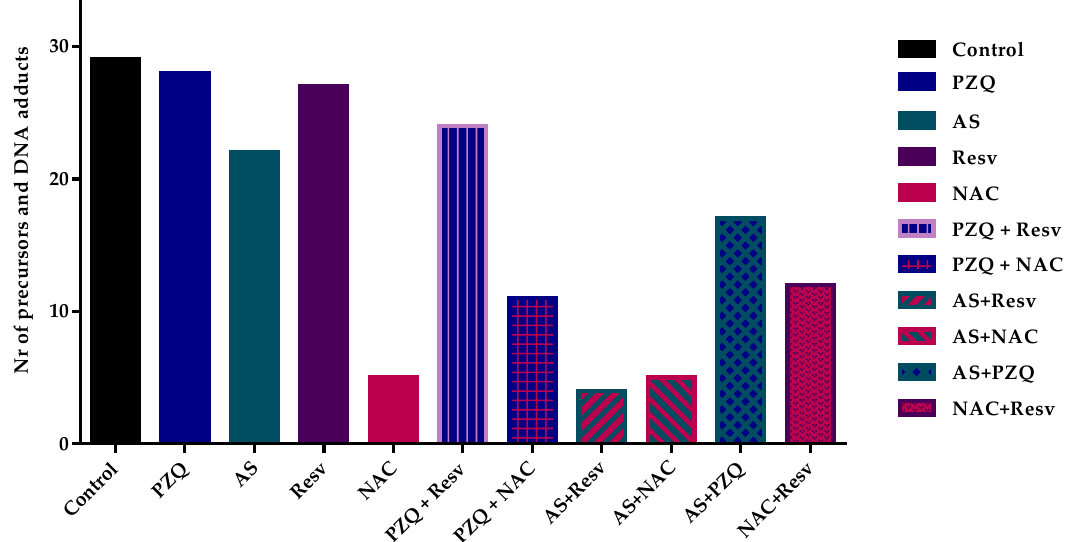
Figure 2. Graphical representation of the number of metabolite precursors and DNA adducts detected in different samples. In general, combination presented better results than compounds alone with AS + Resv inhibiting the formation most of metabolites precursors and DNA adducts. Additionally, antioxidant NAC also prevents the formation of them.